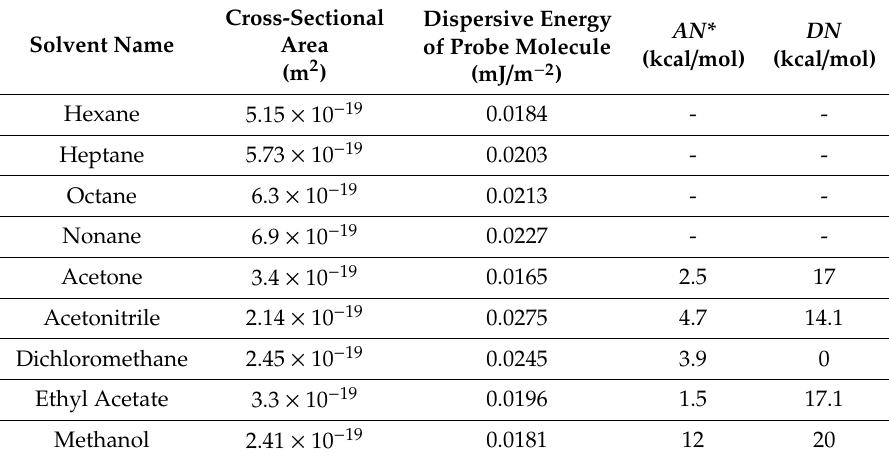
Table 3. The physicochemical properties of probe compounds.